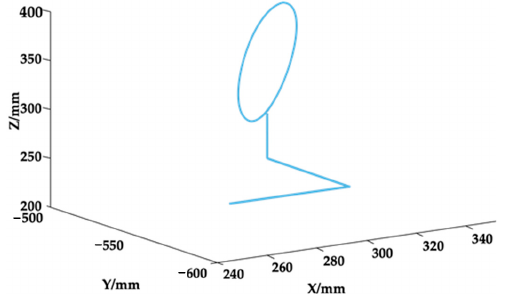
Figure 7. The trajectory diagram.